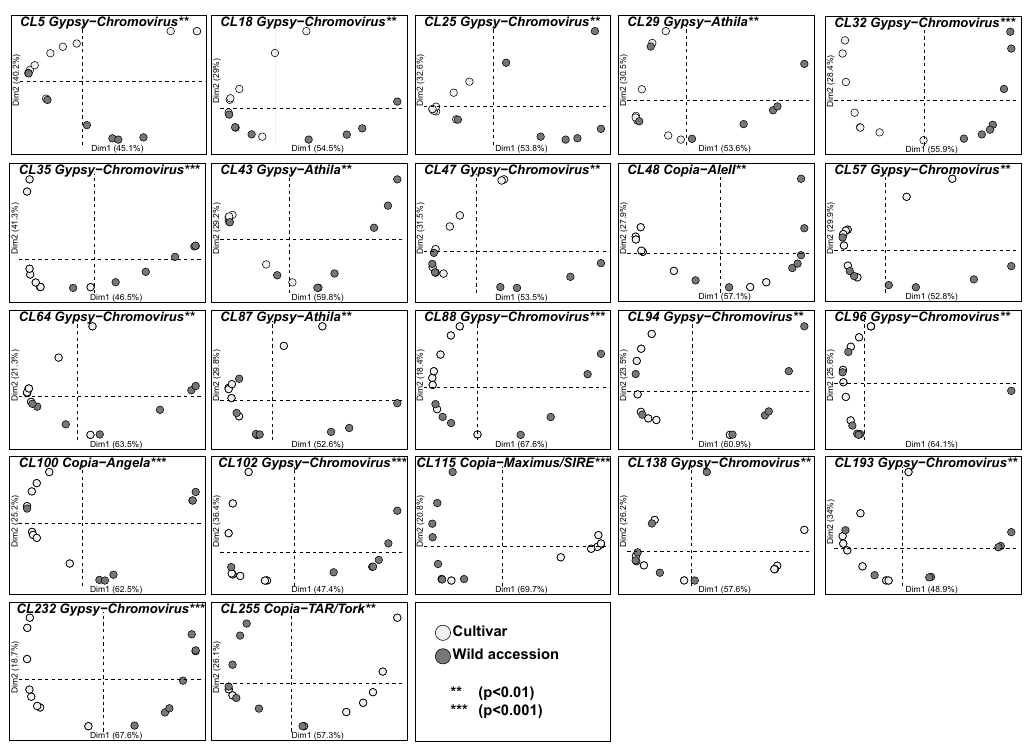
Figure 1. Principal component analysis (PCA) plots of abundance values of 22 LTR-RE families in domesticated (white dots) and wild genotypes (grey dots) of Heliantus annuus . The percentage of variation accounted by each axis is shown. Asterisks indicate permutational multivariate analysis of variance (PERMANOVA) significance between cultivars and wild accessions: *** p < 0.001; ** p < 0.01.